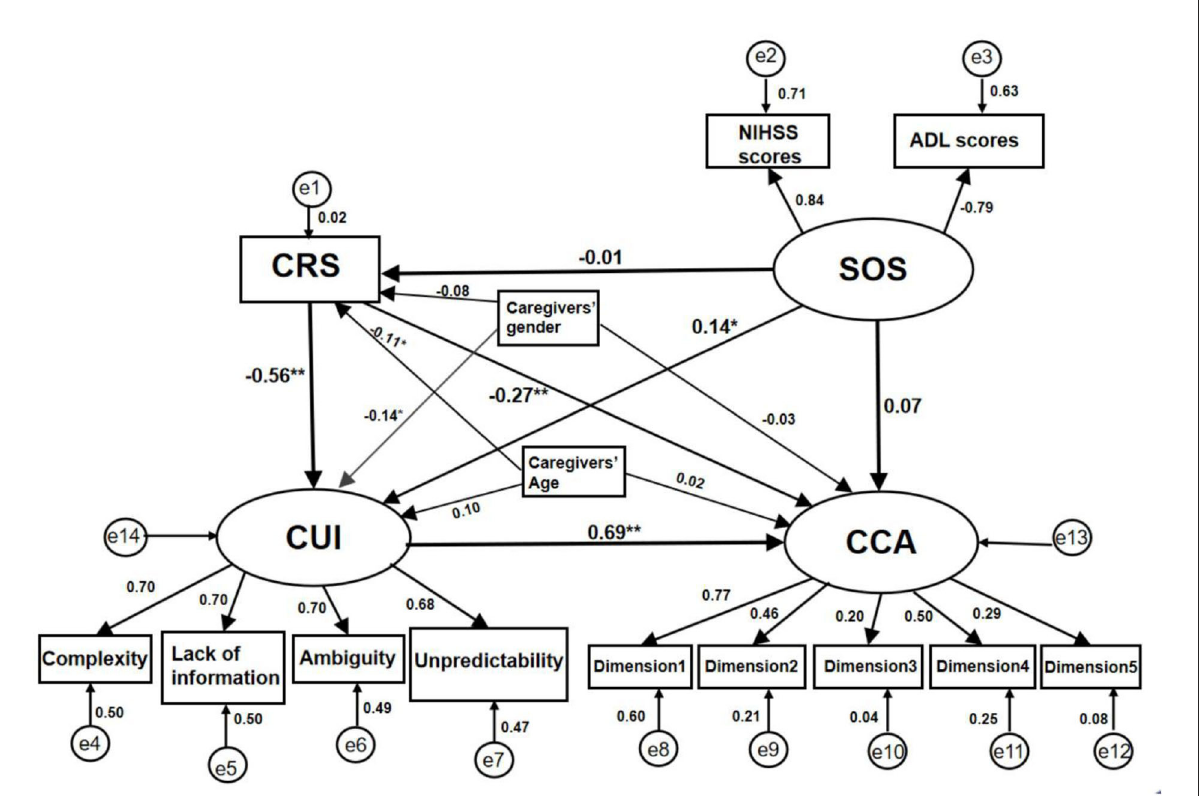
FIGURE2 Standardization coefficient of the SEM in the caregivers of people with stroke. CRS, caregivers’ resilience state; SOS, the severity of stroke; CUI, caregivers’ uncertainty in illness; CCA, caregivers’ caregiving ability; Dimension 1 = Learning to cope with a new role; Dimension 2 = Providing care with the care-receiver’s needs in mind; Dimension 3 = Managing one’s own emotional needs; Dimension 4 = Appraising supportive resources; Dimension 5 = Balancing caregiving needs and one’s own needs; * P < 0.05; ** P <